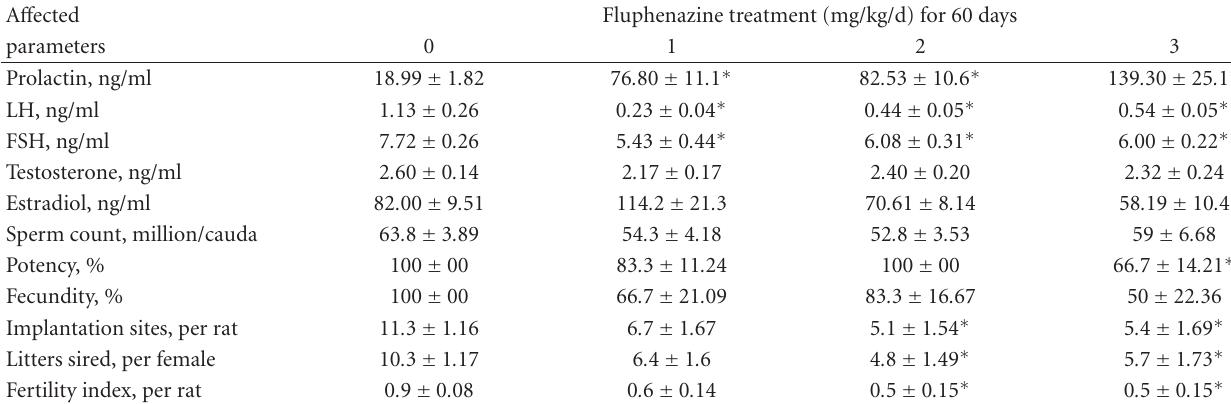
Fluphenazine was dissolved in sesame oil and injected s.c. Male rats were mated at 60 days of treatment and serum hormones analyzed by RIA. Uterine horns of mated females were exposed to count implantation sites, ovaries for corpora lutea. All values are expressed as mean ± SEM. Dose “0” represents control values. ∗ denotes significance at P ≤ . 05 as compared to controls. Potency = % mated females; fecundity = % male rats siring at least one viable pup; fertility index = ratio of implantation sites to corpora lutea; litter size = number of pups per female